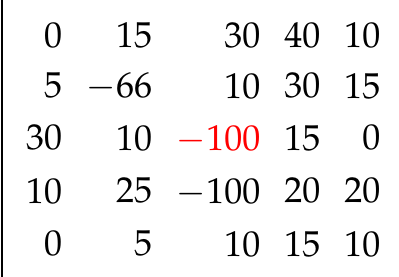
Figure 4. The 2D data subgrid representing ( 3, 3 ) . 3 N